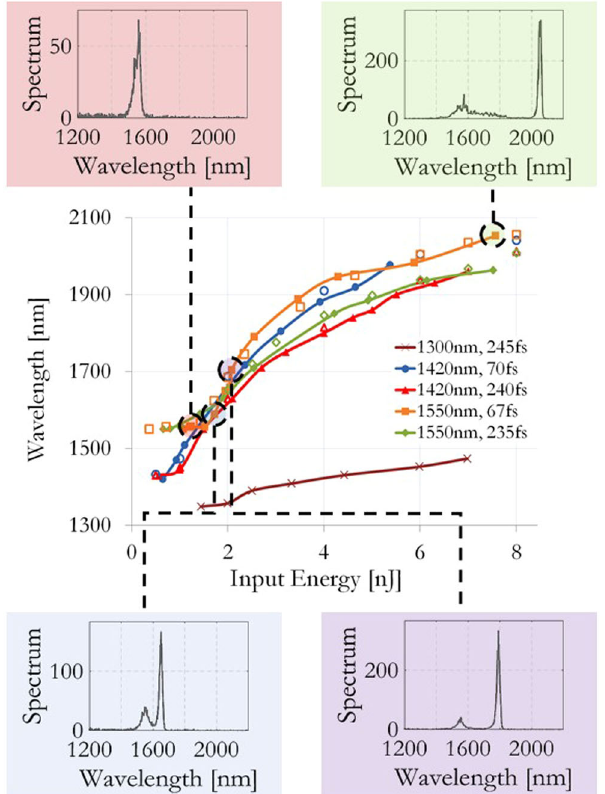
Fig. 3 Measured soliton wavelength vs. input pulse energy, after 120 m of graded-index (GRIN) fi ber, in the cases of Fig. 1. The insets show the measured output spectra, for an input wavelength 1550 nm and pulsewidth 67 fs. Spectrometer resolution is 0.2 nm, which is too small to be visible at this scale.